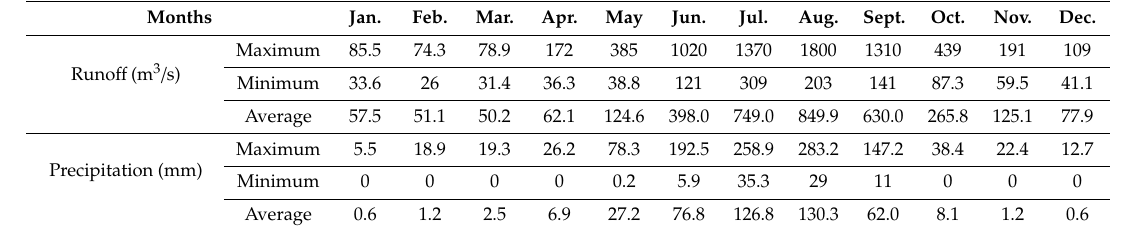
Table 2. Runo ff and precipitation for each month at the Lhasa Hydrological Station and the Lhasa Meteorological Station.